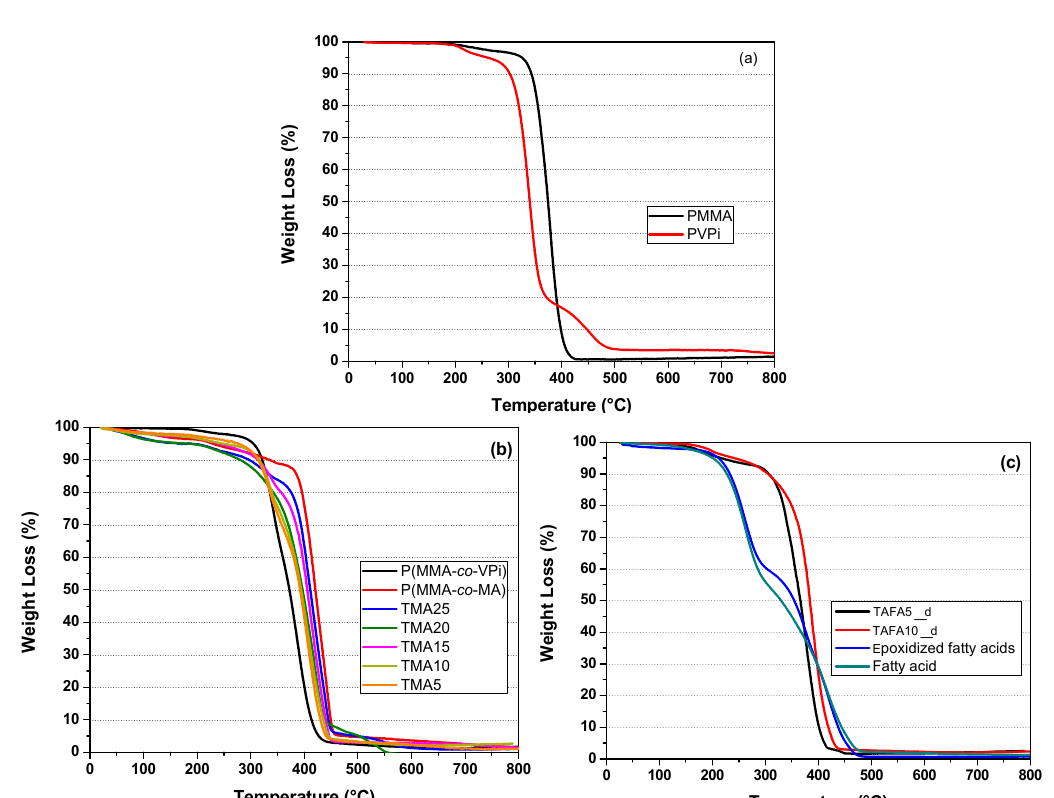
Figure 6. Thermogravimetric analysis of the polymeric materials. ( a ) Methyl methacrylate (MMA) and vinyl pivalate (VPi) homopolymers, ( b ) MMA/VPi and MMA/MA copolymers and MMA/VPi/MA terpolymers, ( c ) MMA/VPi/AFA terpolymer with 5 wt% of acrylated fatty acids, MMA/VPi/AFA terpolymer with 10 wt% of acrylated fatty acids and fatty acid.